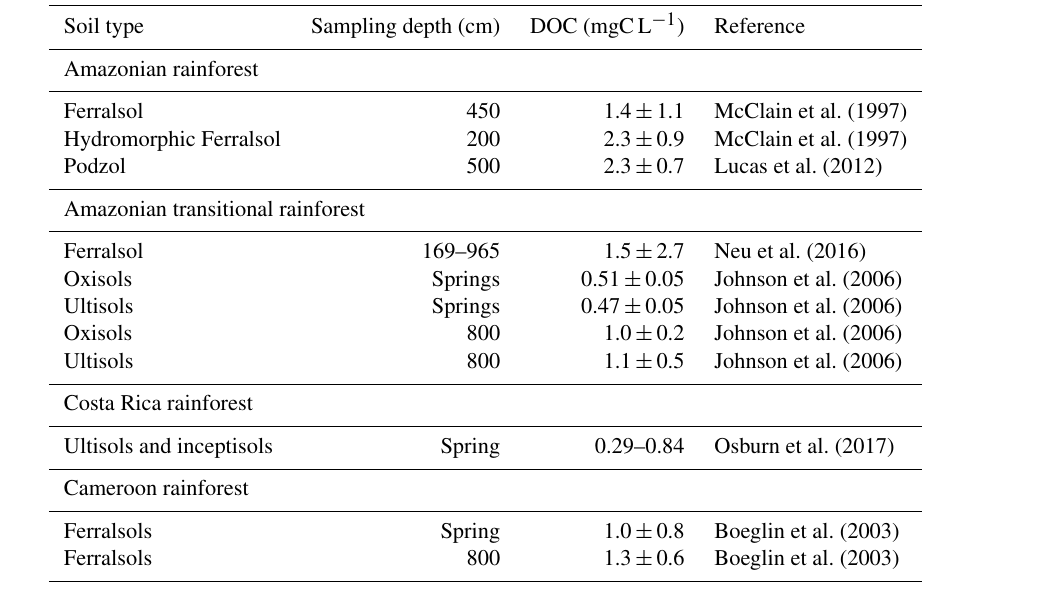
Table 1. DOC content in deep percolating solutions.